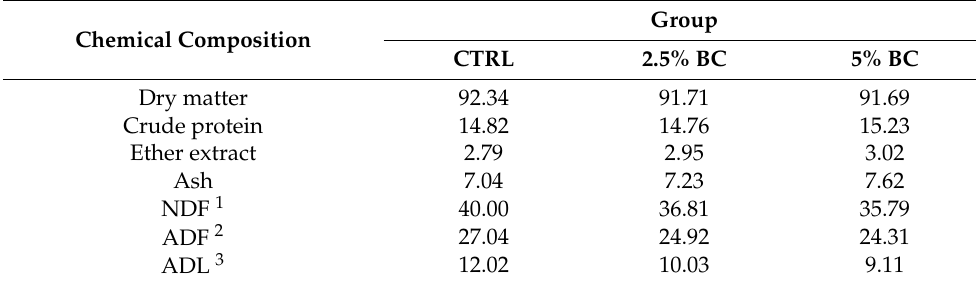
Table 1. Analytical chemical composition of control (CTRL) and experimental diets supplemented with 2.5% (2.5% BC) and 5% (5% BC) of bovine